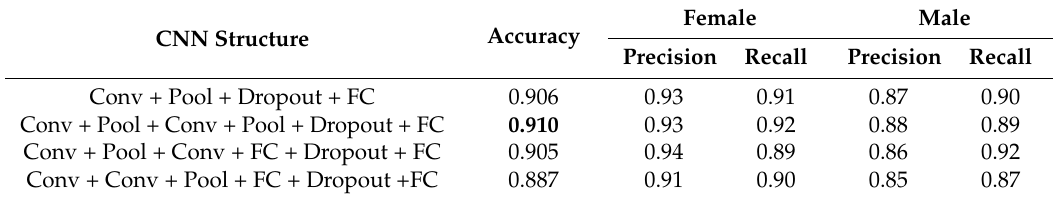
Table 8. Comparison of CNN performance according to the